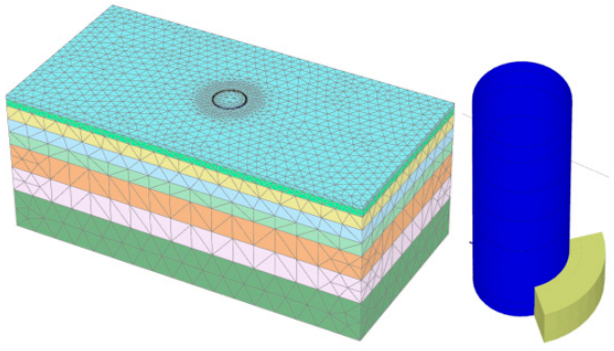
Figure 6. Diagram of finite element numerical model.